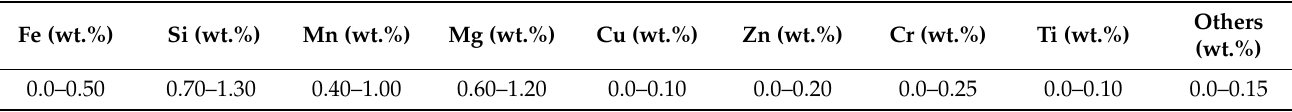
Table 1. Standard chemical composition of aluminum alloy